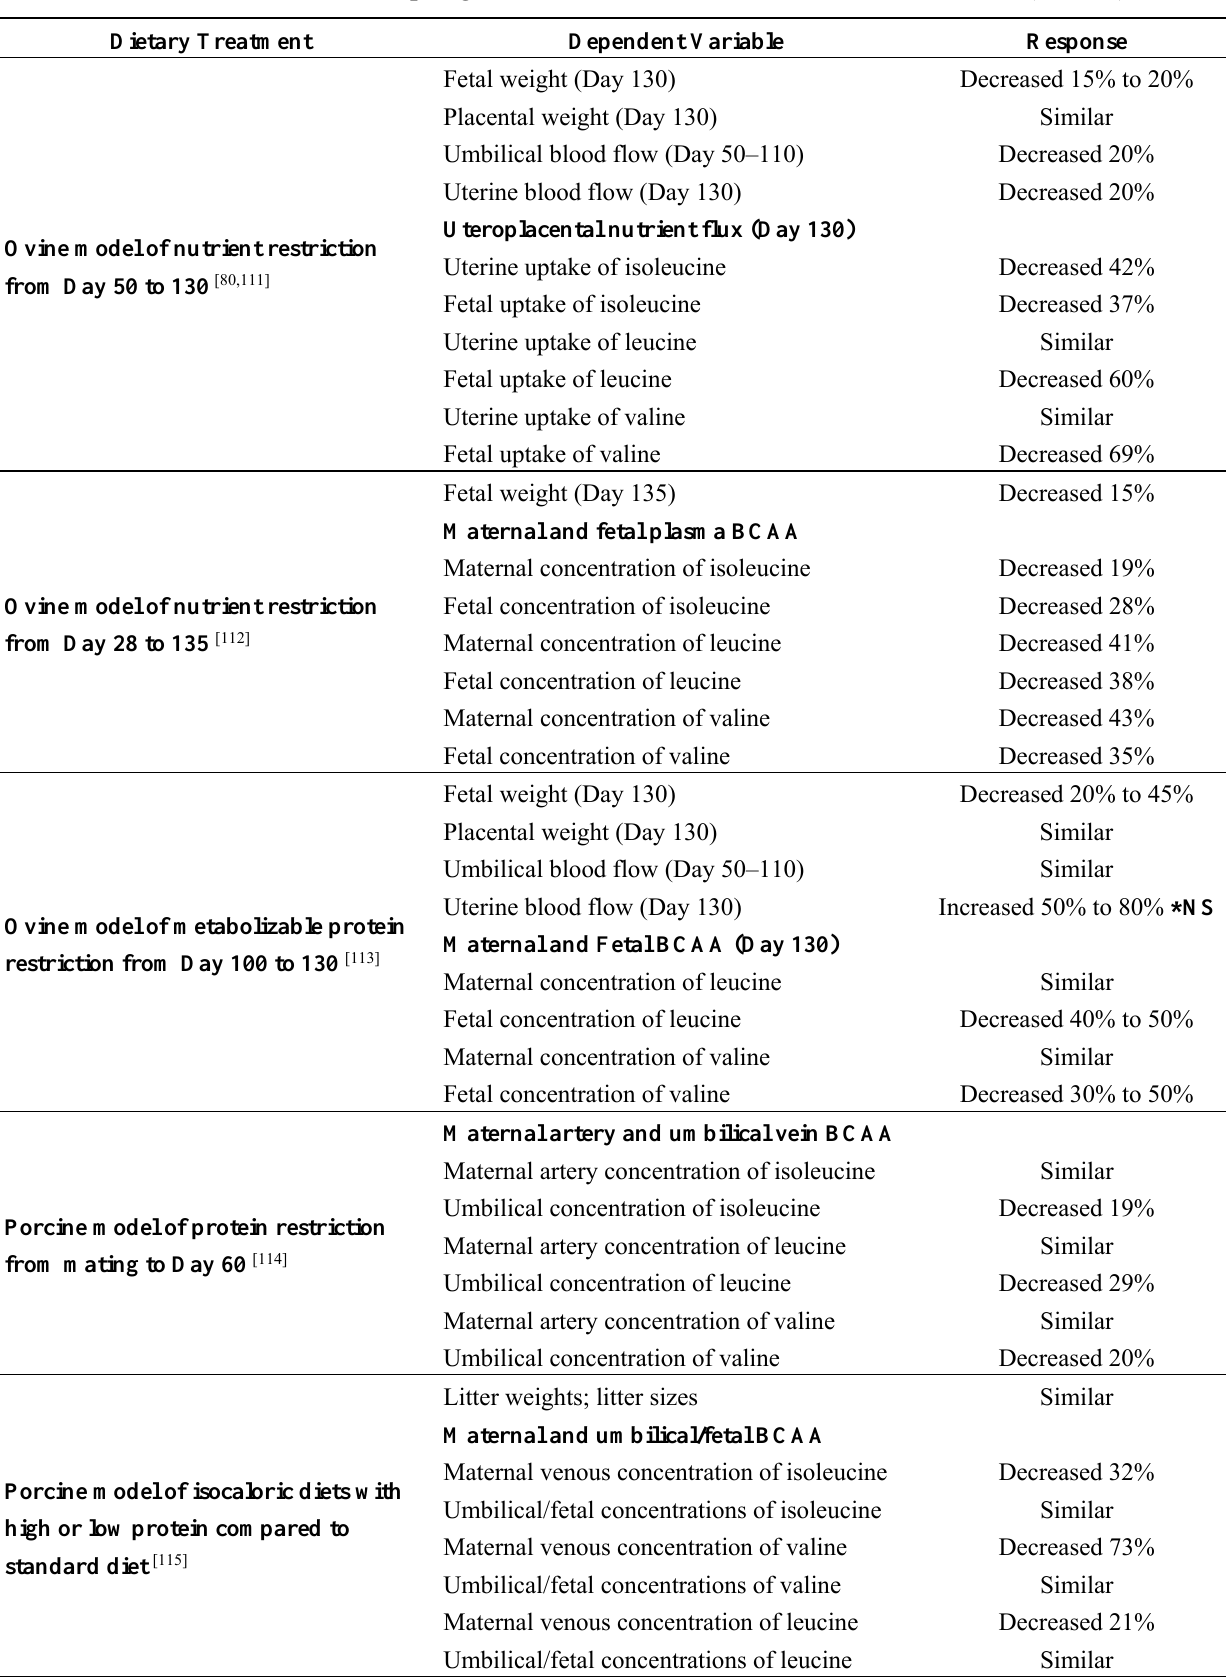
Table 5. Maternal and offspring measurements of branched-chain amino acid